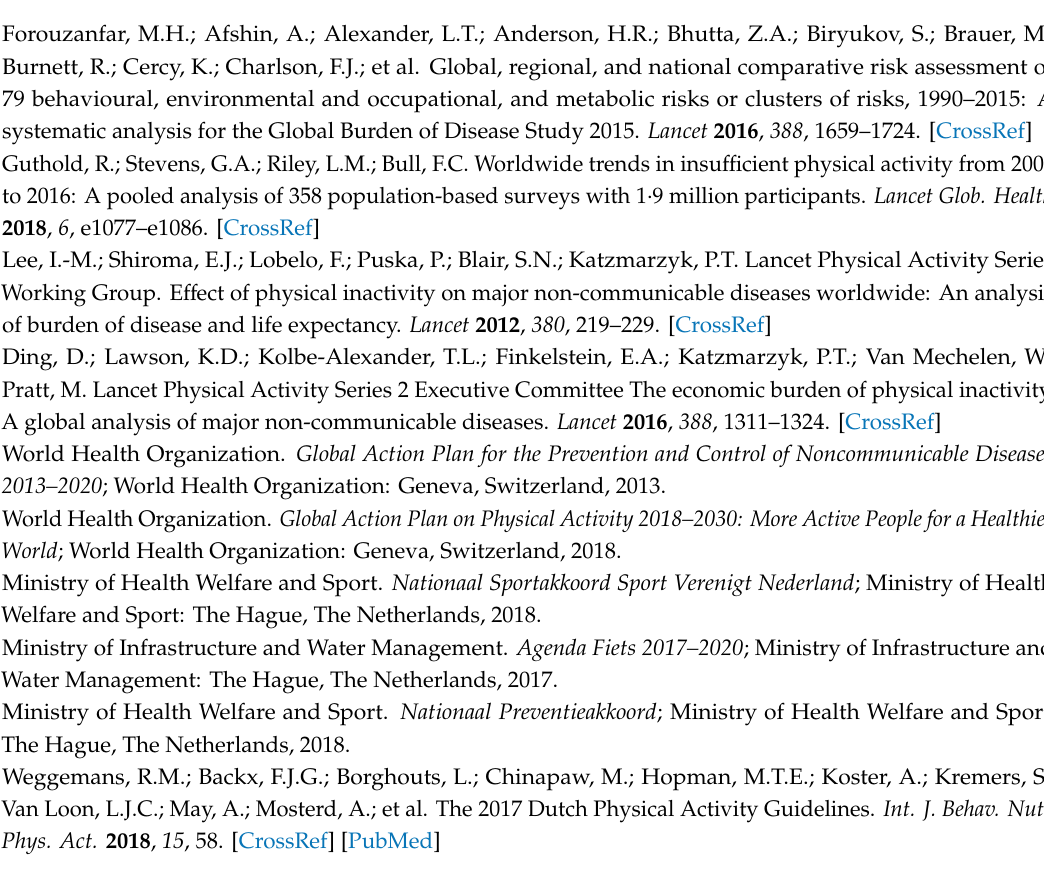
* Based on population size of ≥ 12 years old. † Based on population size of ≥ 25 years old and categorized by highest δ attainedlevelofeducation. low(no, elementary, orlowvocational / secondaryschooling), intermediate(intermediate vocational or intermediate / higher secondary schooling), or high (higher vocational schooling or